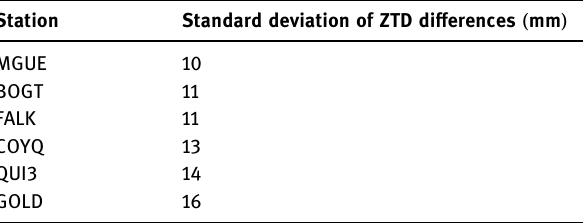
Table 2: Stations with a standard deviation of ZTD di ff erences between SIRGAS - CON and IGS greater than 10 mm